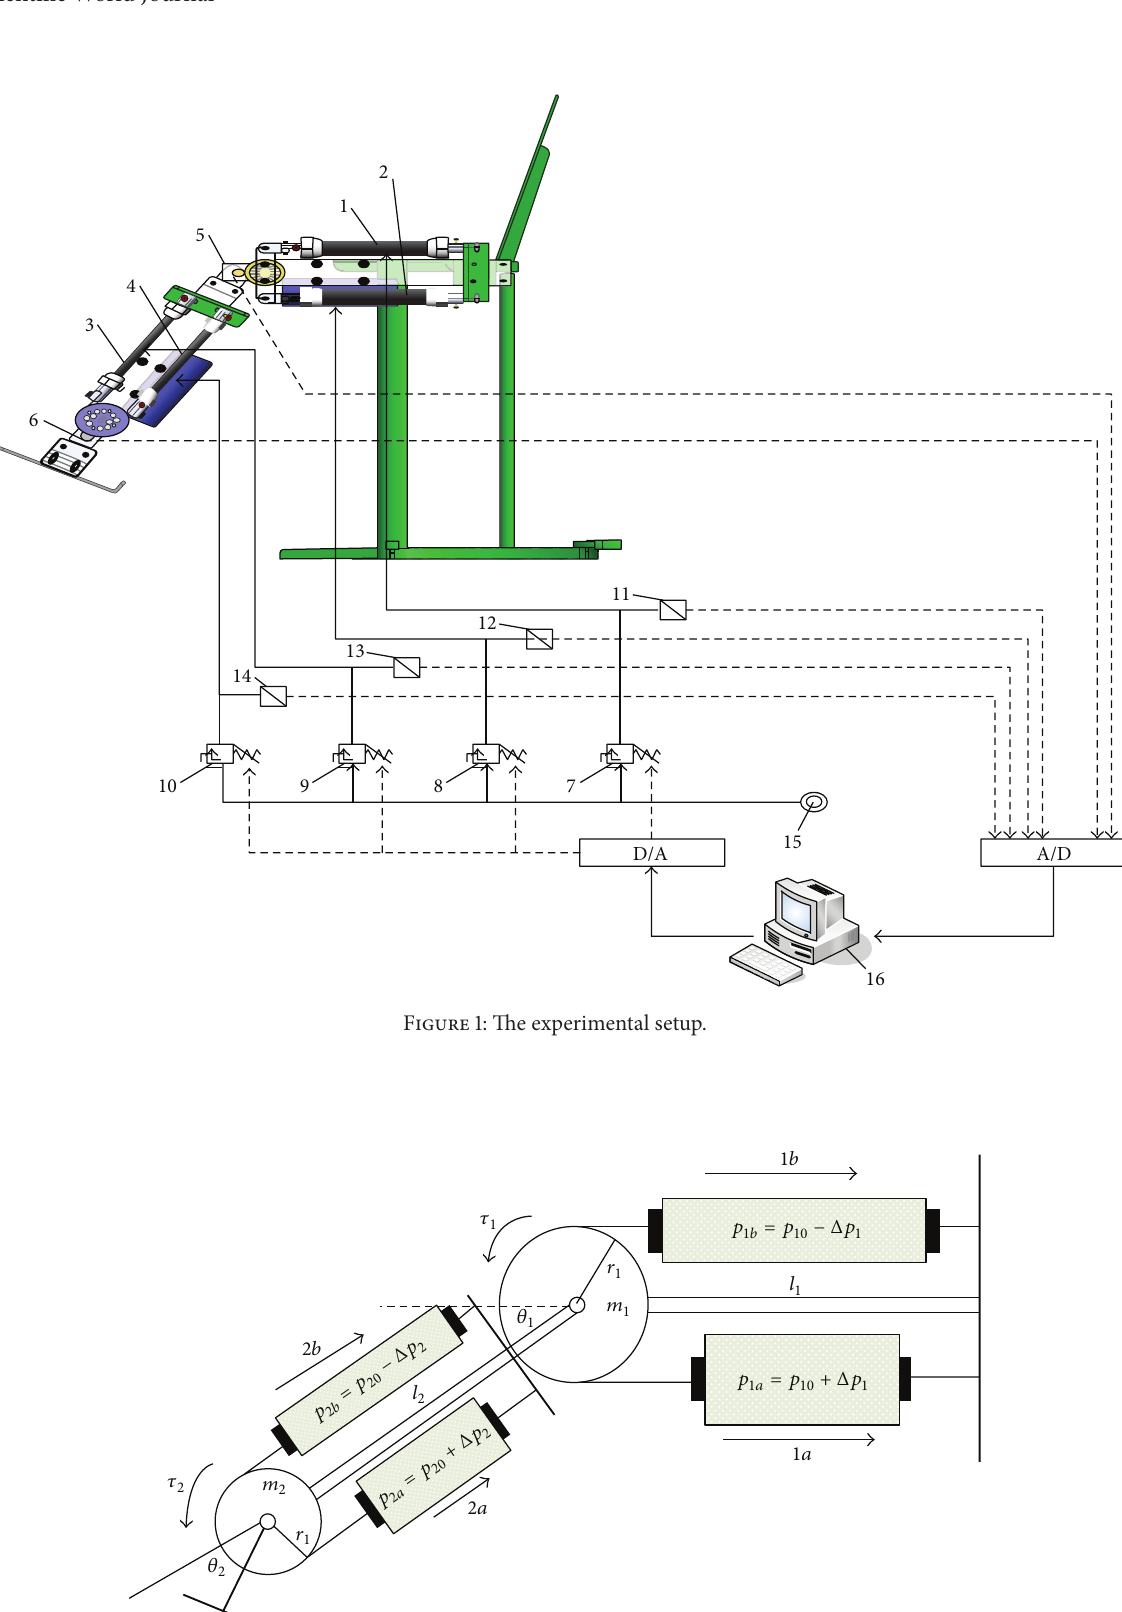
Figure 2: Operation principle of the leg rehabilitation machine driven by